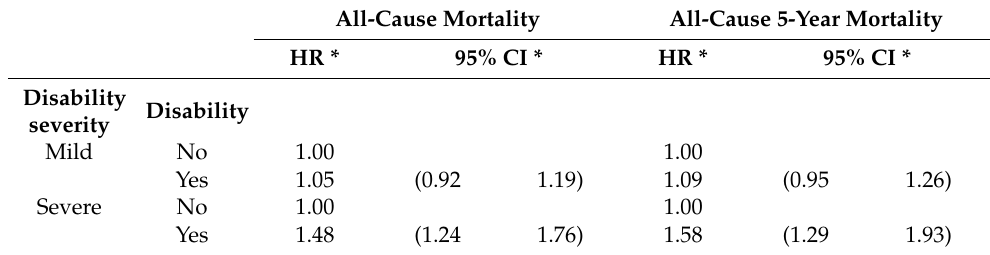
Table 3. Results of the subgroup analysis.